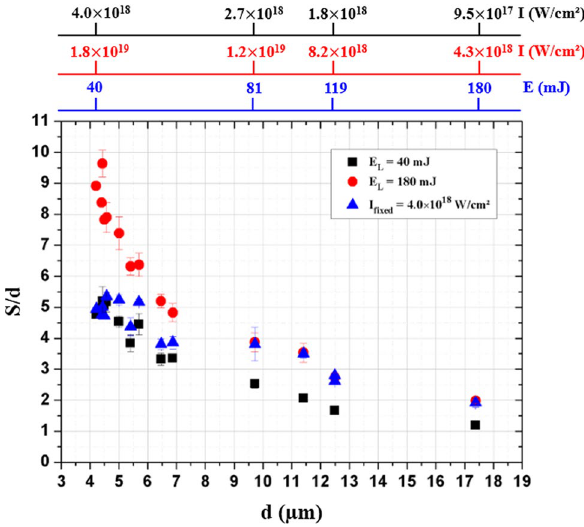
Figure 5. Ratio between the x-ray source size (S) and the laser focal spot size (d) versus laser focal spot size for two constant laser energies (40 mJ—black square and 180 mJ—red point) and for a fixed maximum laser intensity on target (4.0 × 10 18 W/cm 2 —blue